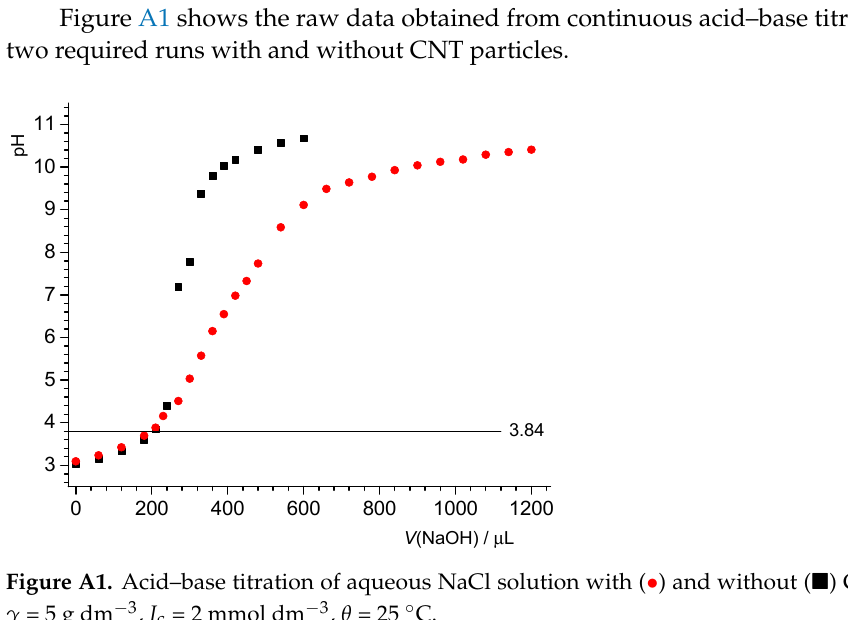
Figure A1. Acid–base titration of aqueous NaCl solution with ( ● ) and without ( ■ ) CNT particles. γ